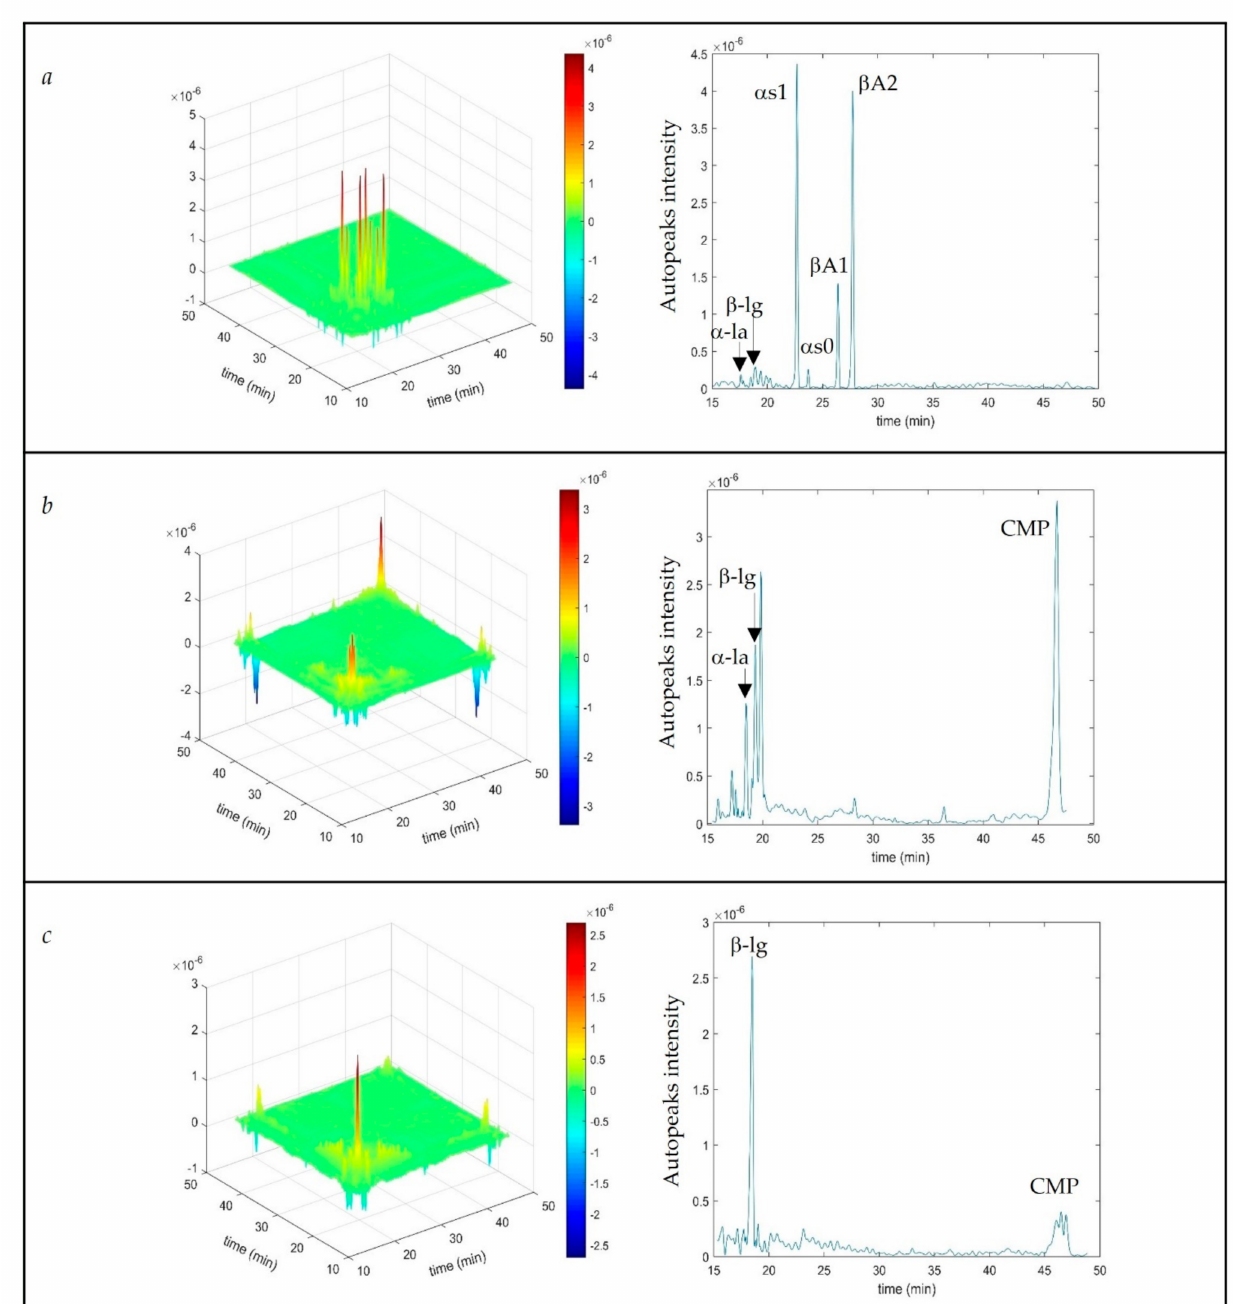
Figure 2. 2DCOR (synchronous) of CE electropherograms of protein components for the studied cheese-making processes with migration times (left-hand) and the correspondent auto-peaks of the diagonal (CE migration time) of 2DCOR (right- hand). ( a ) Grana type cheese; ( b ) Crescenza lab test; ( c ) Crescenza pilot scale. Red color = high positive